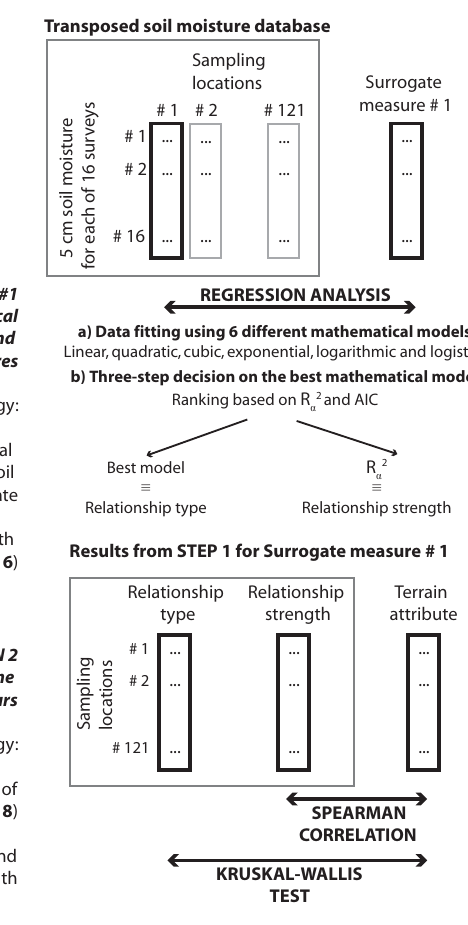
Fig. 3. Methodological approach used in this paper. R 2 α refers to the adjusted coefficient of determination while AIC refers to the Akaike Information